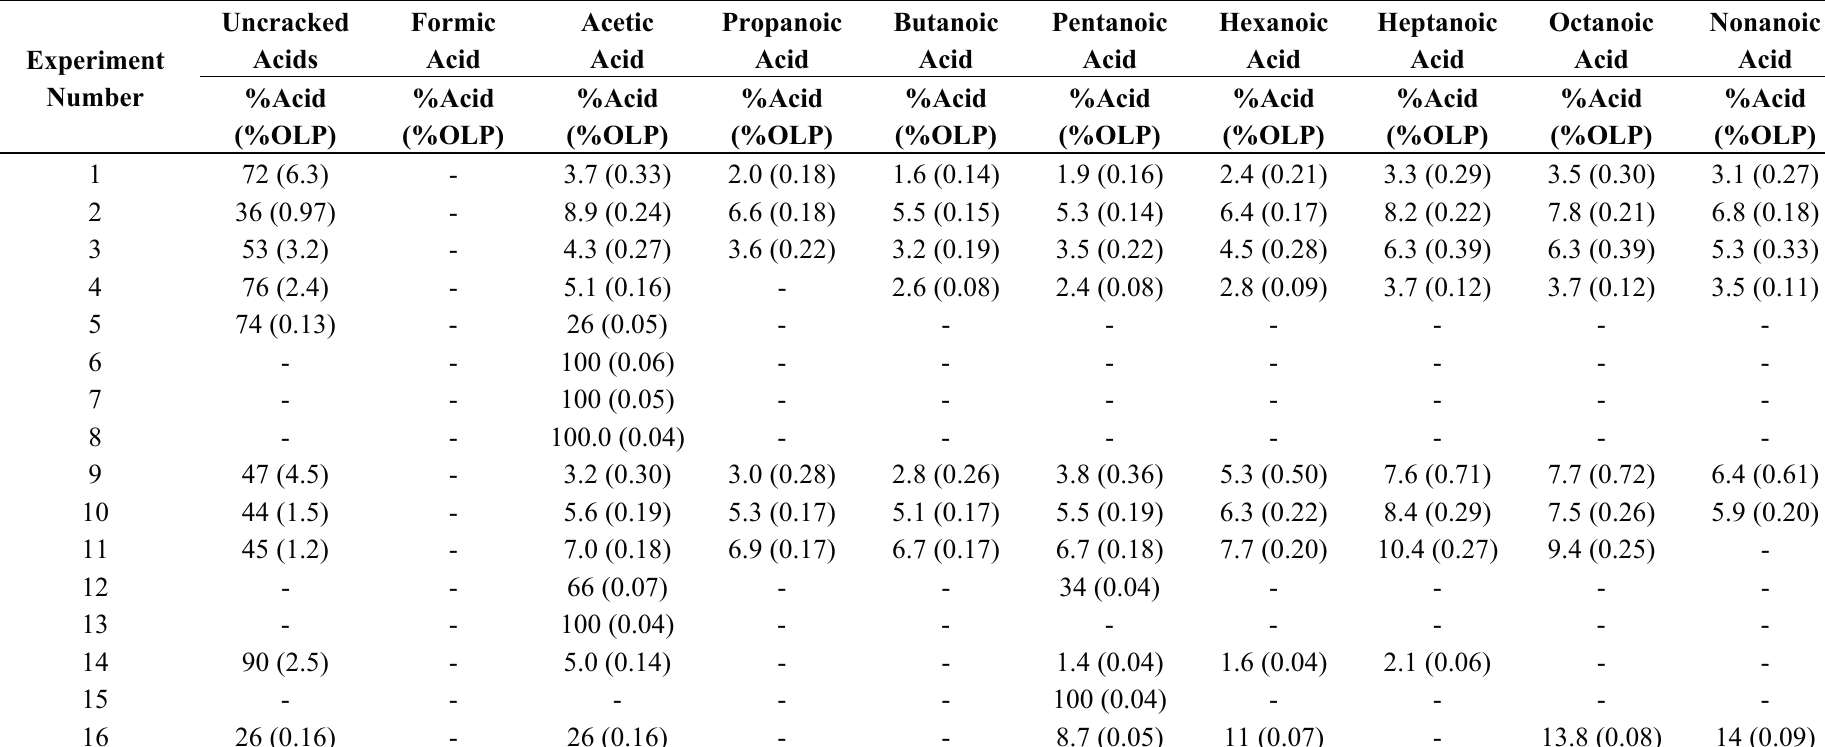
Table 4. Fatty acids distribution results from catalytic cracking soybean oil (concentration in wt% based on total acid and